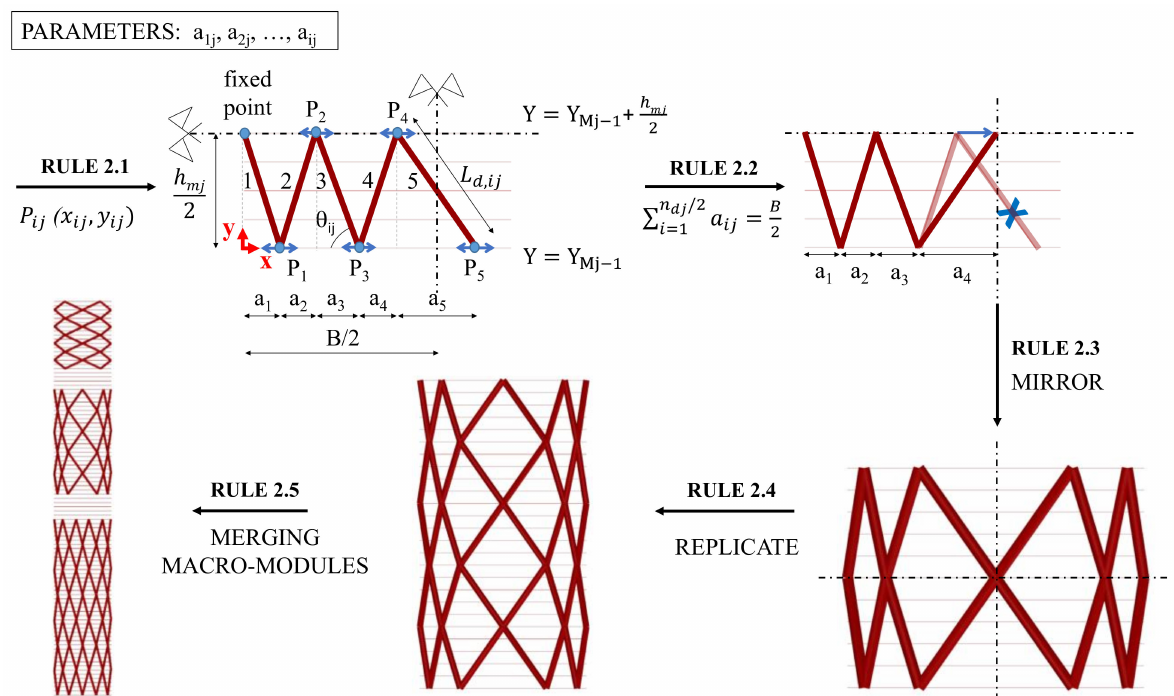
Figure 4. Rules for the discretisation of the design